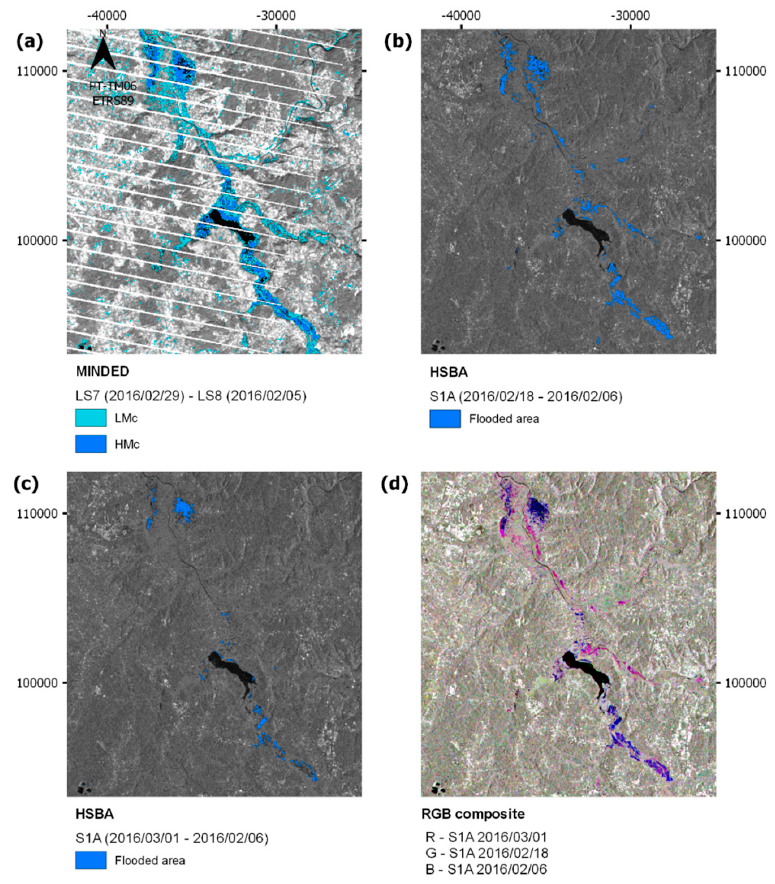
Figure 9. Comparison of flooded areas results for the 2016 event (13 February 2016) within the ROI, obtained with: ( a ) MINDED (NIR band of LS7 29 February 2016 in the background); ( b , c ) the HSBA algorithm-considering two different post-event images (S1A IW GRDH from 18 February 2016 and 1 March 2016 respectively, represented in the backgrounds); ( d ) False color RGB composite: R-S1A obtained 16 days after the event (1 March 2016), G-S1A obtained 5 days after the event (18 February 2016), B-S1A reference image 7 days prior to the event (6 February 2016) (Coordinate System: PT-TM06/ETRS89). Table 9. Confusion matrix between results of MINDED and HSBA methods, analyzed in terms of No Change (Nc) and Flooded areas (LMc + HMc), for the event of 13 February 2016, within the region of interest.